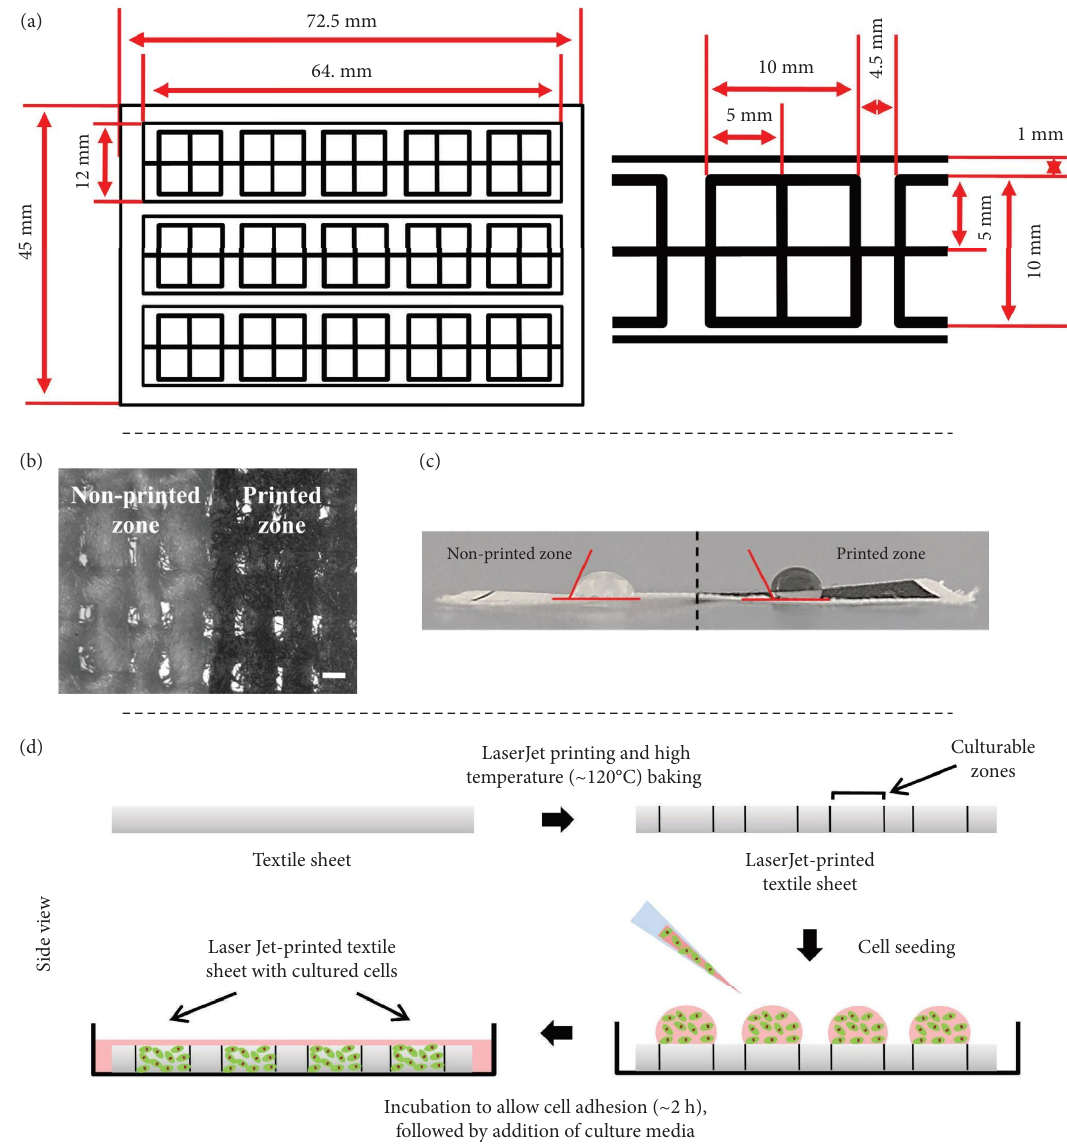
Figure 1: Textile-based devices for cell culture applications. (a) Design specifcations of the devices. (b) Micrographs of the textile-based devices showing the diferences in the printed and nonprinted zones. Te printed zones showed the presence of coating of melted toner ink particles (40x magnifcation and scale bar: 200 μ m). (c) Contact angle measurement of the printed (hydrophobic, contact angle: ∼ 112.5 ° ) and nonprinted (hydrophilic, contact angle: ∼ 70.5 ° ) zones of the textile devices. (d) Schematics demonstrating the preparation and cell seeding on the textile devices. Representative images for cell seeding on the textile device have been provided in supplementary fgure